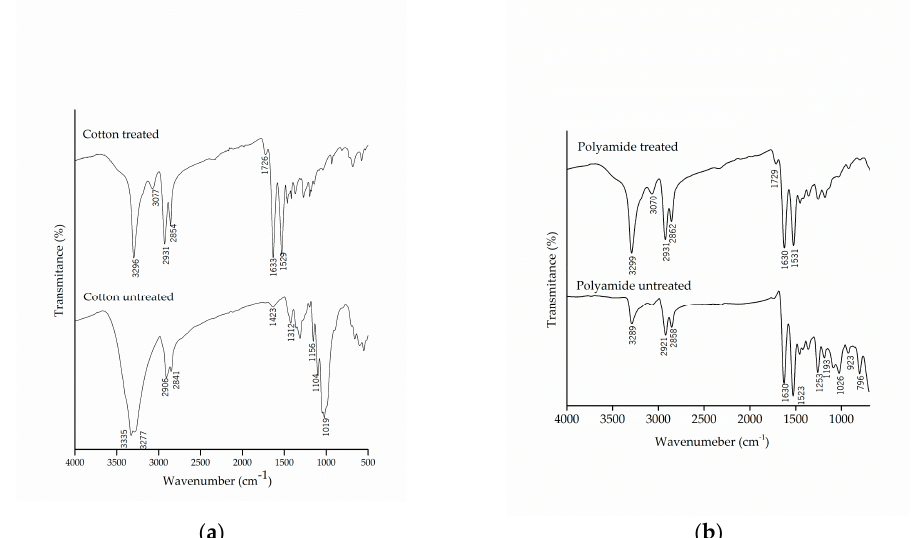
Figure 4. Infrared spectrum with attenuated reflectance (FTIR/ATR) of pure and treated ( a ) cotton and ( b ) polyamide substrates.